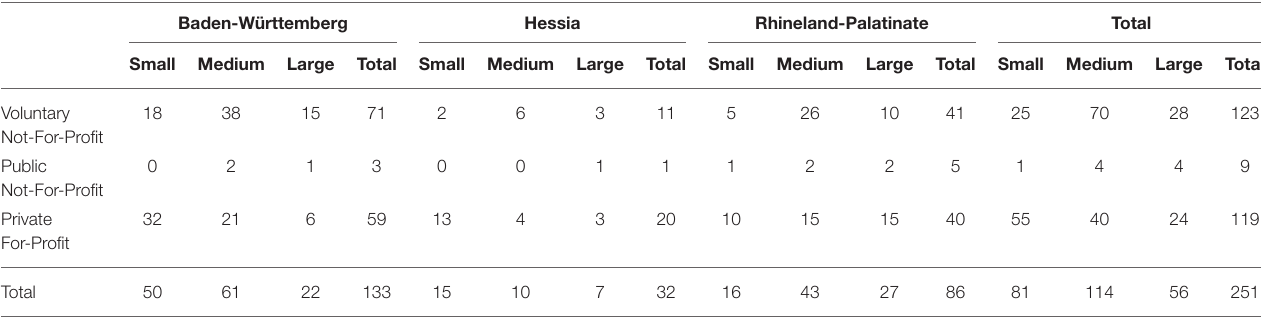
TABLE 3 | Residential long term care facilities in the German region Metropolregion